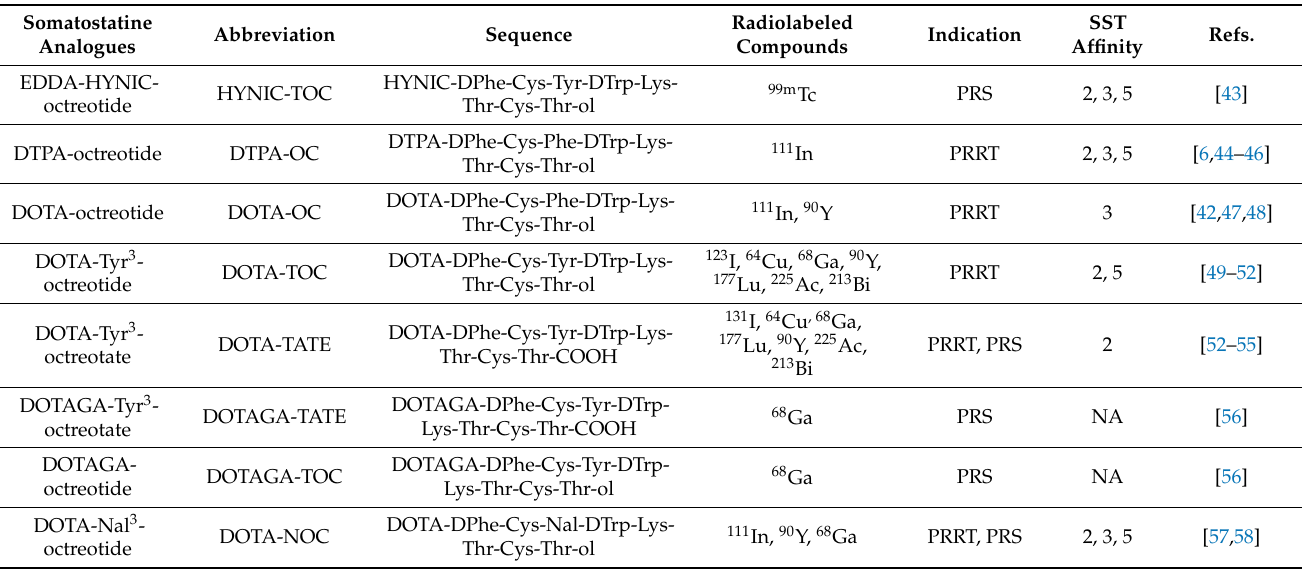
Table 2. Evaluation and expression of diverse derivatives of octreotide and their probable applications for diagnosis or therapy in confronting SSTR subtypes [28,42].